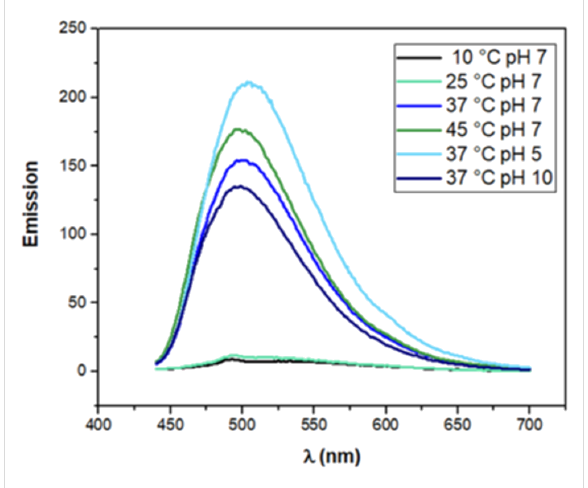
Figure 1: Emission spectra of systems containing 0.01% (w/w) P407, 1.6 × 10 − 4 % (w/w) C974P and 1.8 × 10 − 5 mol/L CUR at 10 °C, 25